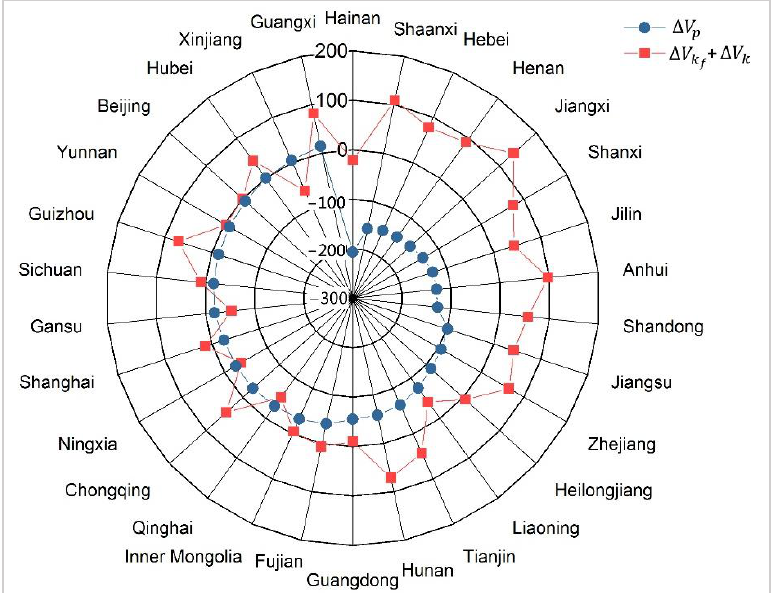
Figure 5. Relationship between the effect of installed capacity mix and capacity factors from 2015 to 2019.